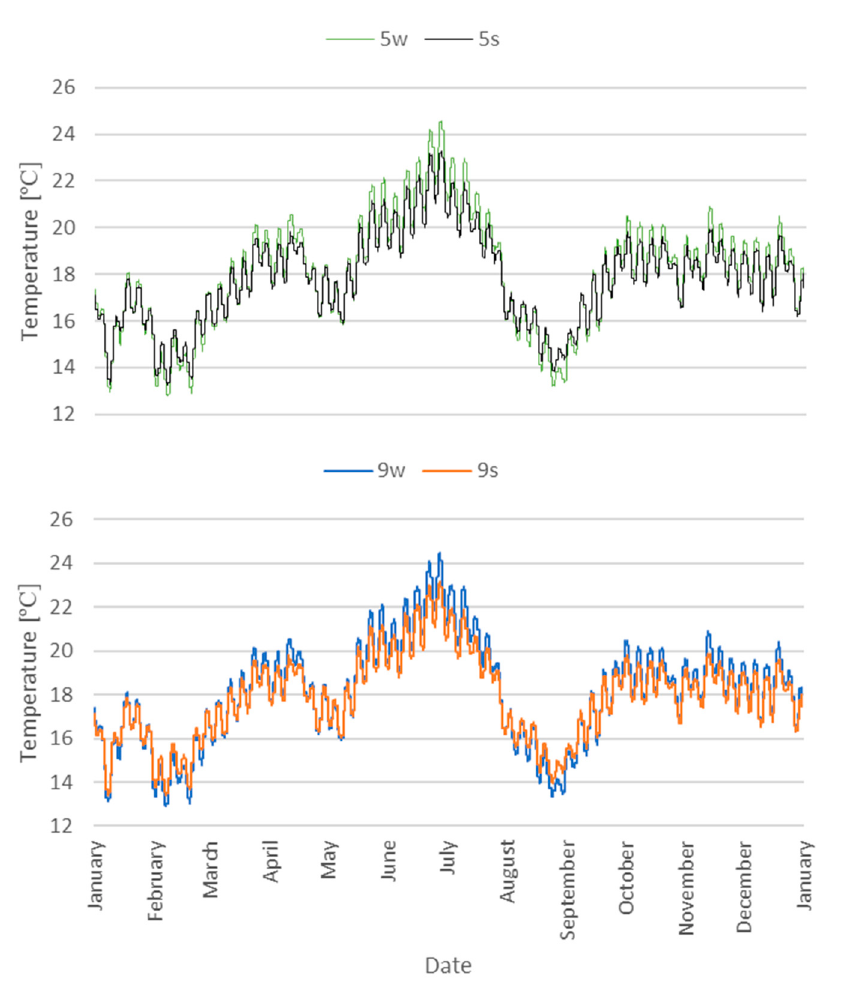
Figure 12. Floor temperature in variants 1 and 2, at points 5w and 9w as well as 5s and 9s.